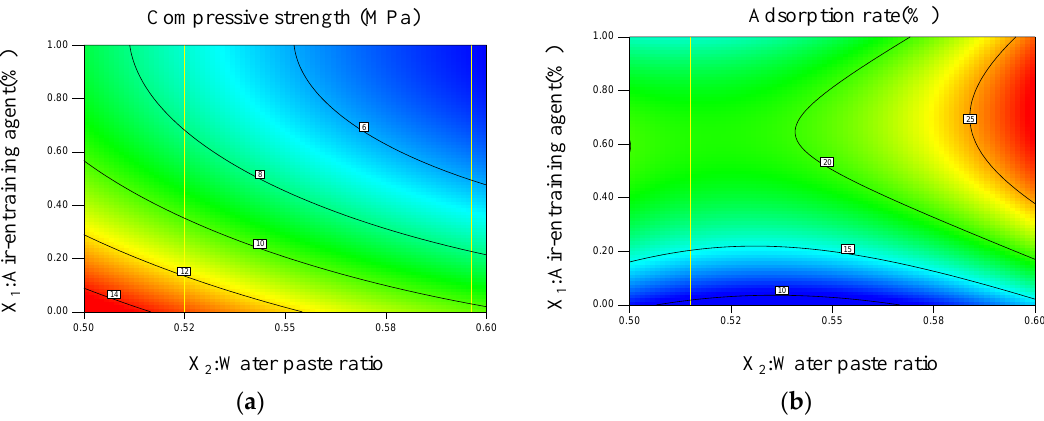
Figure 4. Response surface contours of the influence of the water – paste ratio and the air-entraining agent interaction on the ( a ) compressive strength and ( b ) absorption rate of the phosphorous gypsum. Figure 5a,b show the evaluation lines of the predicted values of the compressive strength and the adsorption rate.